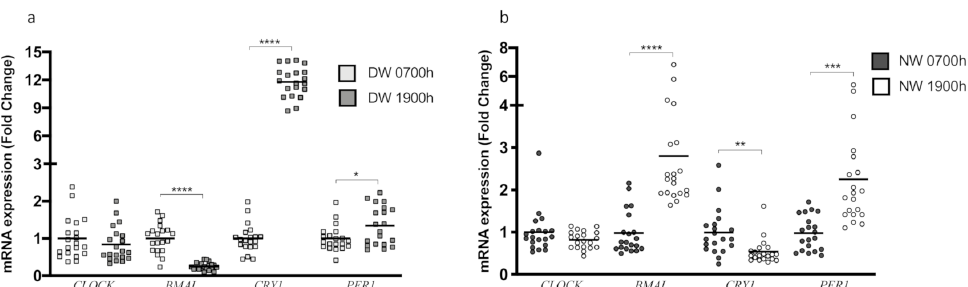
Figure 3. Determination of the gene expression of clock genes in peripheral blood mononuclear cells (PBMC) samples of day and night workers at different times. Gene expression was evaluated by RT-qPCR ( n = 20 per group). ( a ) Gene expression of the clock genes of day workers at 0700 h and 1900 h. ( b ) Gene expression of the clock genes of night workers at 0700 h and 1900 h. Data are presented as dot plot with mean. Unpaired, one-tailed t -test. Data were normalized for values at 0700 h.